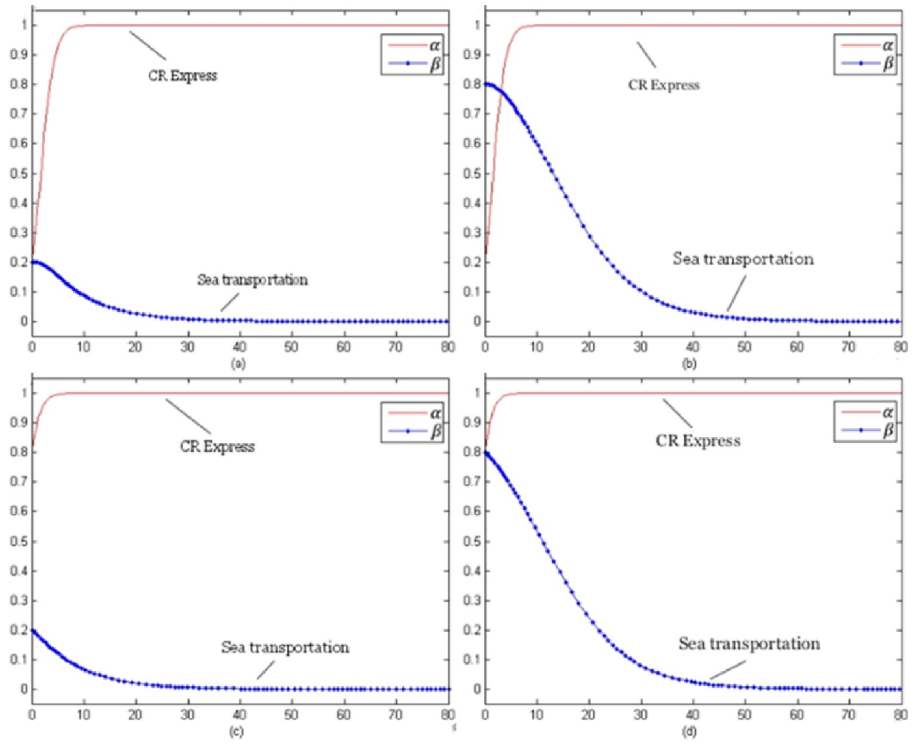
Fig 3. Evolution trends of laptop transportation competition game (with